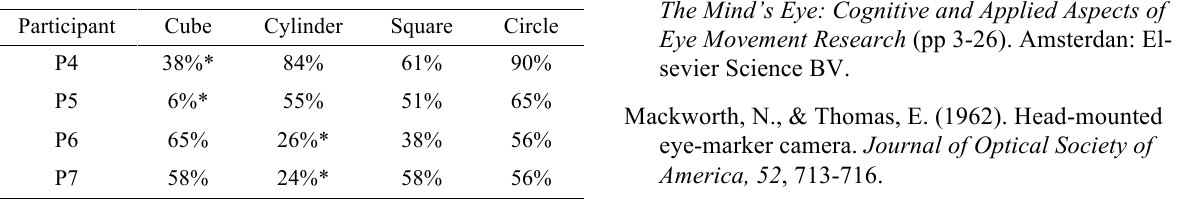
Figure 4. The average of the four participants’ time spent fixating figures (duration in seconds) across the four blocks of trials. The bars, from left to right, show the av- erage from the most to the least fixated figure. Percent reduction in time spent fixating each figure from the first to the last block of